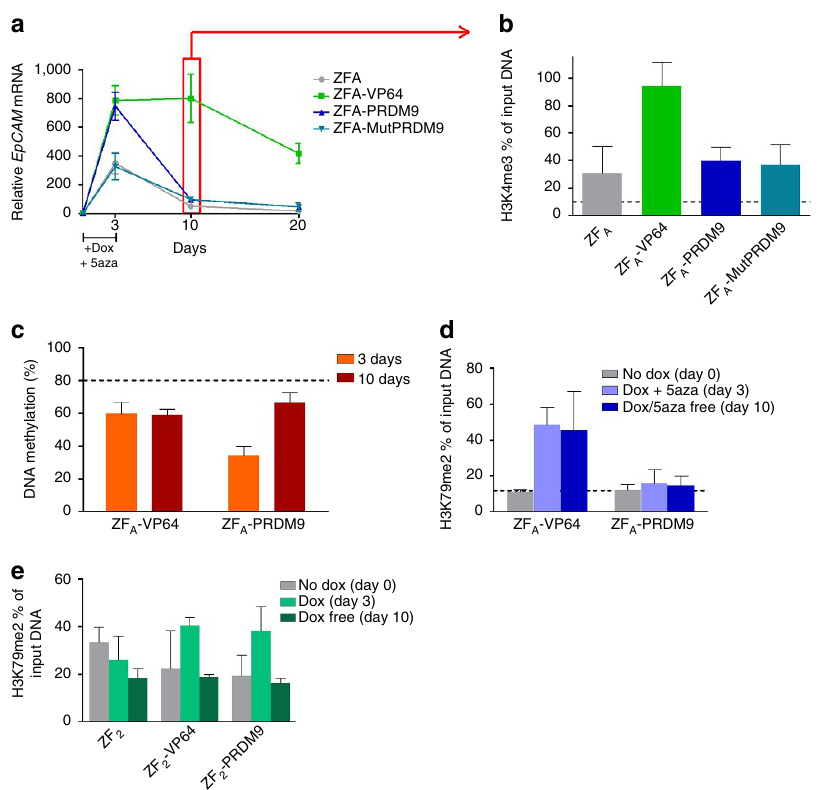
Figure 5 | Stability and maintenance of H3K4me3 after DNA demethylation. ( a ) Relative EpCAM messenger RNA (mRNA) expression, at each specific time point after using the inhibitor of DNA demethyltransferases 5 0 aza for 3 days. ( b ) H3K4me3 ChIP–qPCR enrichment at the promoter region of EpCAM 10 days after demethylation and ZF fusion protein expression. ( c ) DNA methylation levels at the EpCAM promoter determined by pyrosequencing, black-dot line represents mean methylation levels of untreated cells. ( d ) H3K79me2 ChIP–qPCR enrichment at the promoter region of EpCAM 3 and 10 days after demethylation and ZF fusion protein expression. ( e ) H3K79me2 ChIP–qPCR enrichment at the promoter region of PLOD2 3 and 10 days after ZF fusion protein expression. n ¼ 3 independent experiments; error bars ±